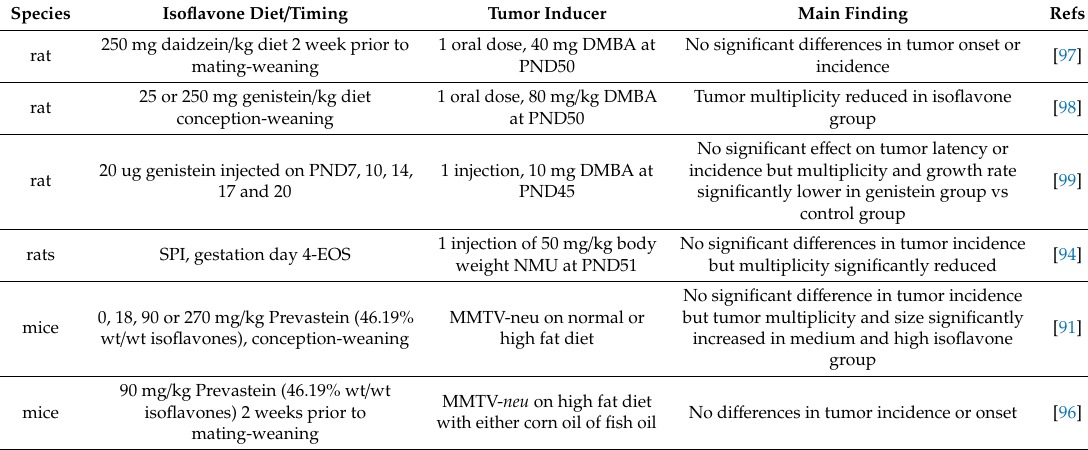
Table 3. Perinatal Soy / Isoflavone